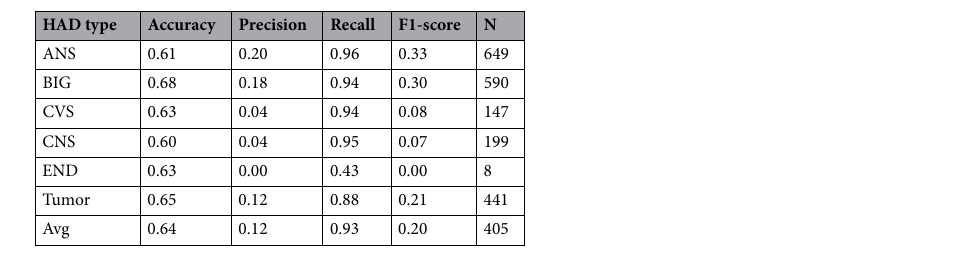
Table 14. Prediction performance on each HAD type in OPD data